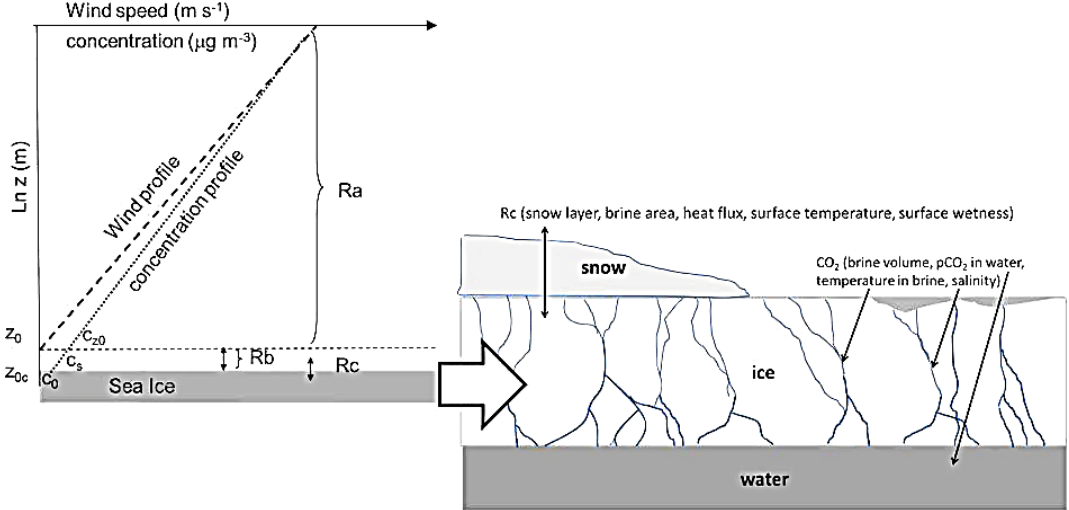
Fig. 1. Left panel: Ra is the aerodynamic resistance over the layer dominated by atmospheric turbulence. Rb is the quasi-laminar boundary layer resistance over the layer, which is influenced by molecular diffusion and turbulence and Rc is the resistance over the ice/snow– atmosphere interface. The dashed line illustrates the logarithmic wind profile over the surface, which in theory goes to 0 at z 0 . The dotted line illustrates the logarithmic concentration profile, which goes to the surface equilibrium concentration ( c s ) at z 0 c . Right panel: Sketch showing Rc and some of the parameters in/at the surface which Rc is affected by and p CO 2 in the brine and parameters affecting